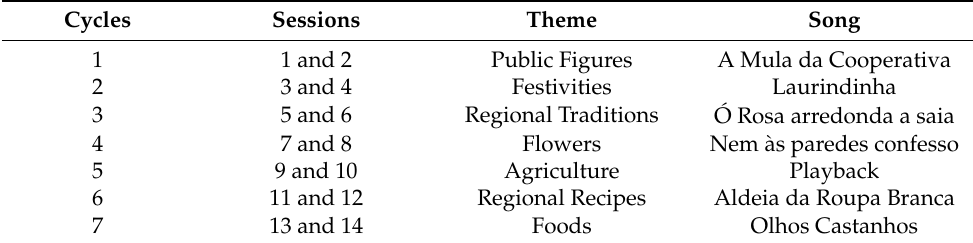
Table 3. Sessions, themes, and songs corresponding to each cycle of